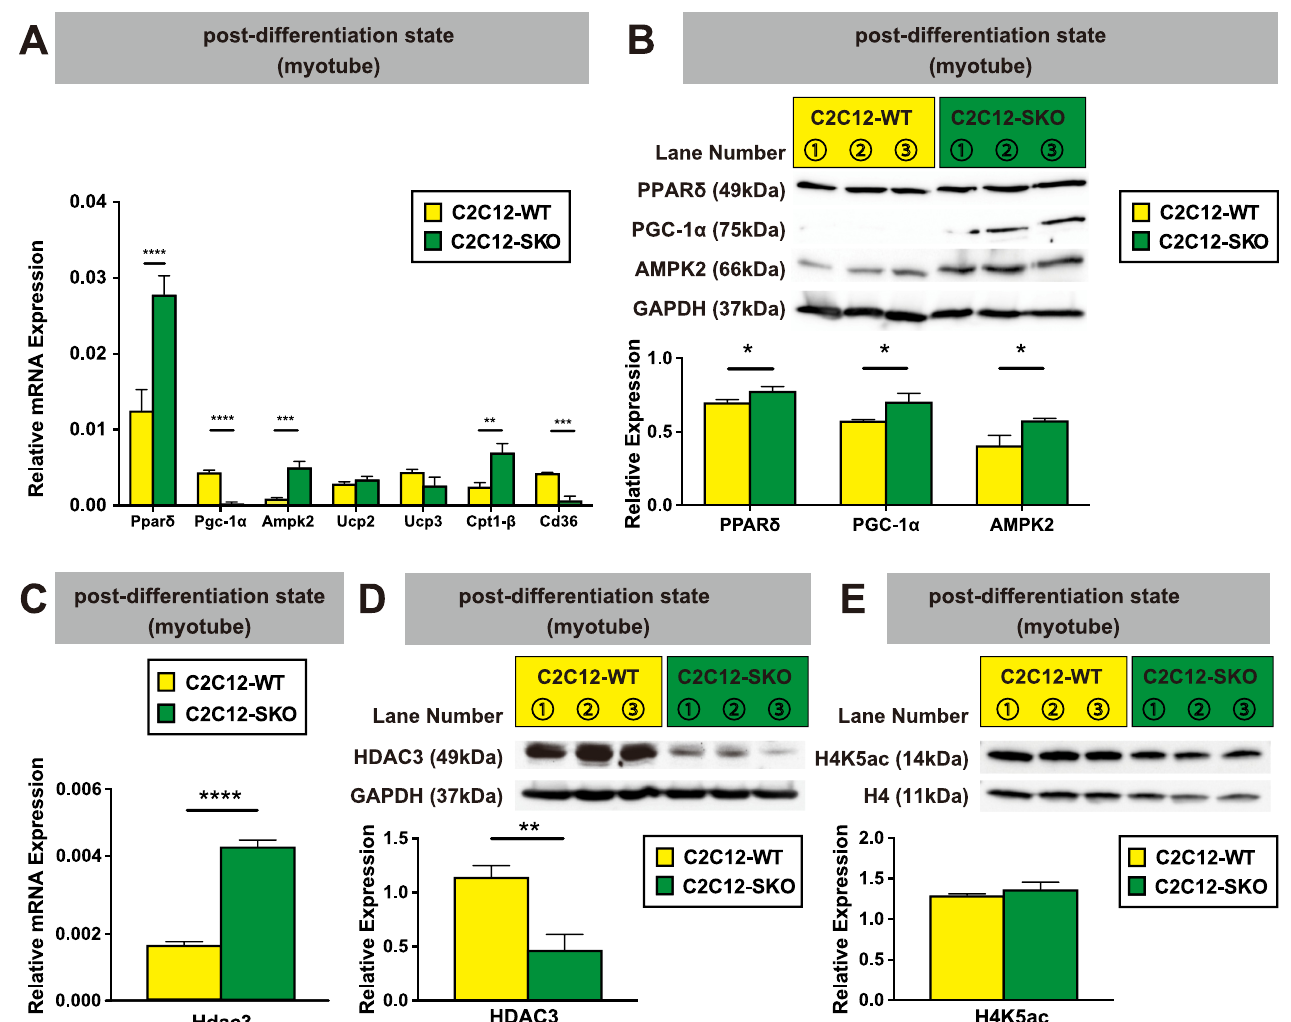
Fig 2. SMRT suppresses β -oxidation during the differentiation of C2C12 cells. (A) The mRNA expressions of β -oxidation-related gene in both C2C12-WT and C2C12-SKO cells were quantified by qPCR (n = 3 per group). (B) Protein expressions of PPAR δ , PGC-1 α and AMPK2 were assessed by WB (n = 3 per group). (C) The mRNA expression of Hdac3 in both C2C12-WT and C2C12-SKO cells was quantified by qPCR (n = 3 per group). (D) Protein expression of HDAC3 was assessed by WB (n = 3 per group). (E) Protein expressions of histone H4K5ac and H4 were assessed by WB (n = 3 per group). Student t-tests were used for statistical analyses in all qPCR and quantification of protein expression. Results are shown as the mean ± SEM (error bars represent SEM), and the p- value are shown as ���� p < 0.0001, ��� p < 0.001, �� p < 0.01, and � p < 0.05.